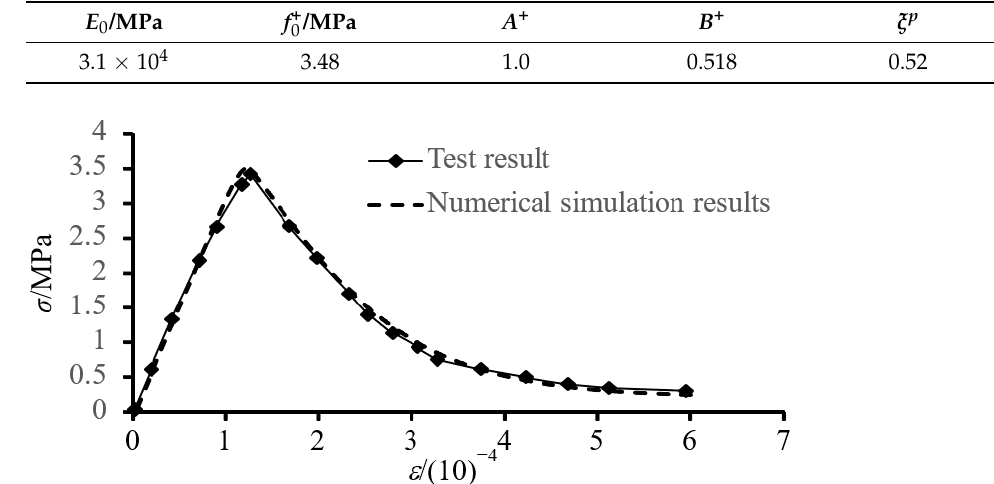
Figure 1. Comparison of numerical simulation result and experimental result (uniaxial tensile test). Table 1. Simulation parameters of the uniaxial tensile test.